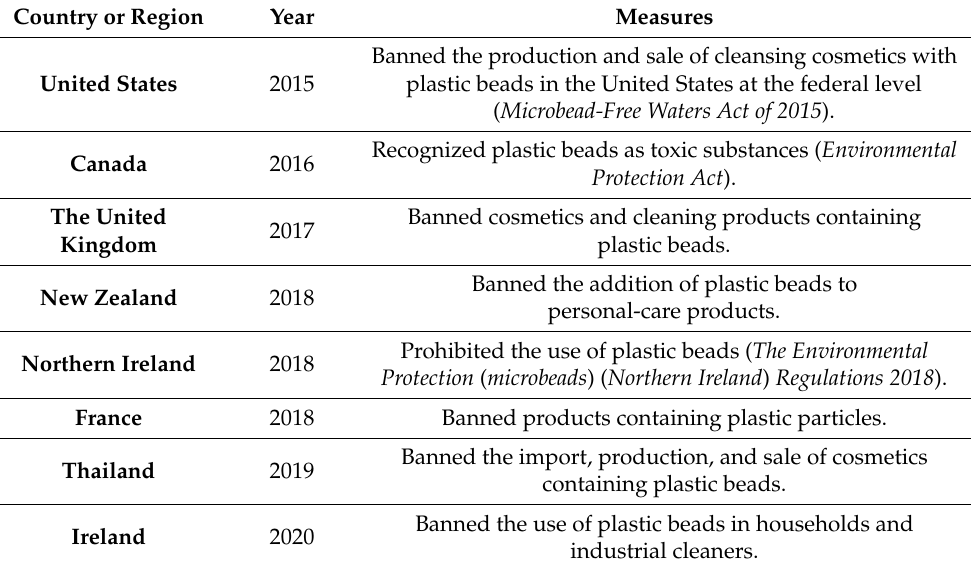
Table 1. National legislation or ban on marine microplastic substances. Country or Region Year Measures Banned the production and sale of cleansing cosmetics with United States 2015 plastic beads in the United States at the federal level ( Microbead-Free Waters Act of 2015 ). Recognized plastic beads as toxic substances ( Environmental Canada 2016 Protection Act ). Banned cosmetics and cleaning products containing 2017 plastic beads. Banned the addition of plastic beads to New Zealand 2018 personal-care products. Prohibited the use of plastic beads ( The Environmental 2018 Protection ( microbeads ) ( Northern Ireland ) Regulations 2018 ). 2018 Banned products containing plastic particles. Banned the import, production, and sale of cosmetics 2019 containing plastic beads.